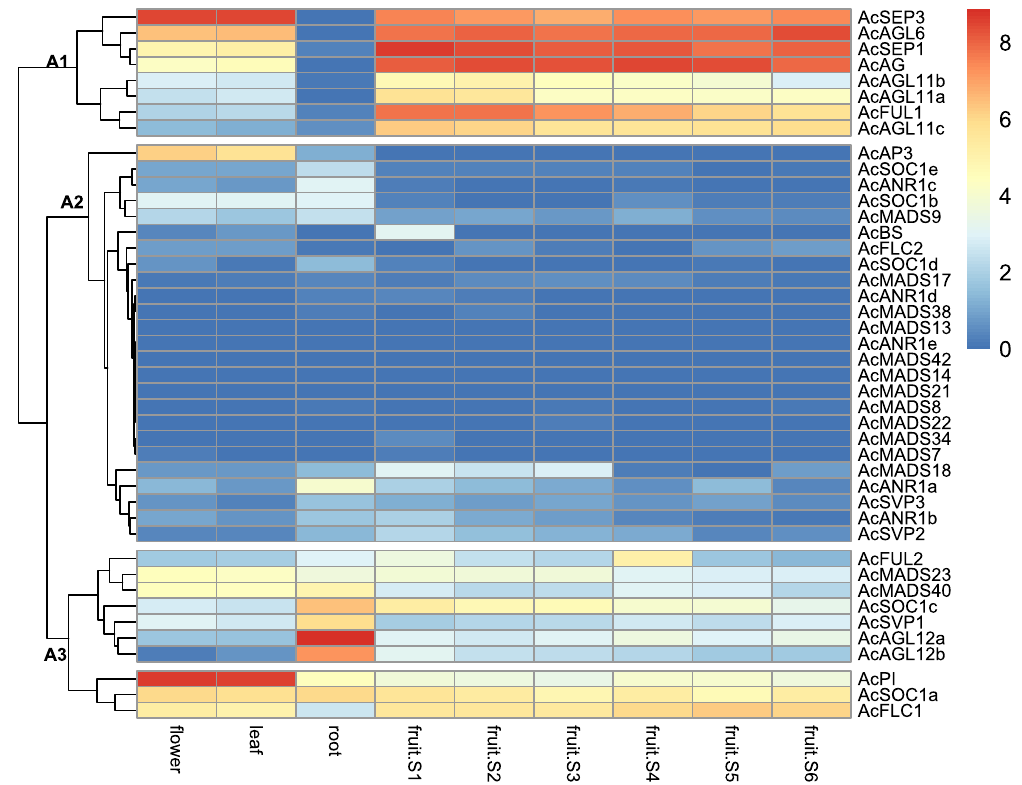
Figure 6. Expression cluster analysis of pineapple MADS-box genes in different tissues and fruit developmental stages. The different tissues and developmental stages included flowers and roots, leaves, and different developmental stages of fruit (S1–S7). The expression value was quantified as fragments per kilobase per million reads (FPKM), and relative gene expression data were gene-wise normalized. Three major expression groups are marked as A1, A2, and A3. The color scale bar is at the top-right corner; blue, white, and red indicate low, medium, and high expression levels,